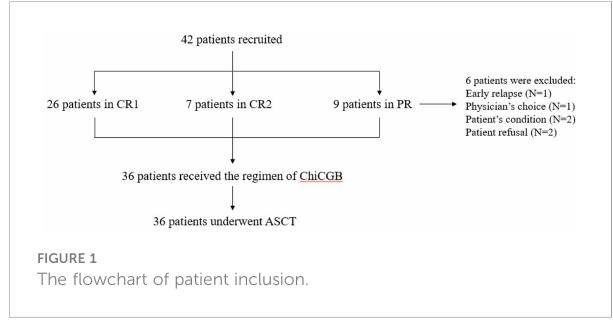
FIGURE 1 The fl owchart of patient